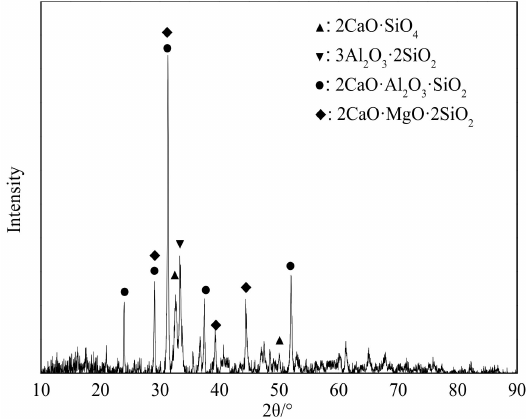
Figure 10. XRD analysis of slag in a typical mixed